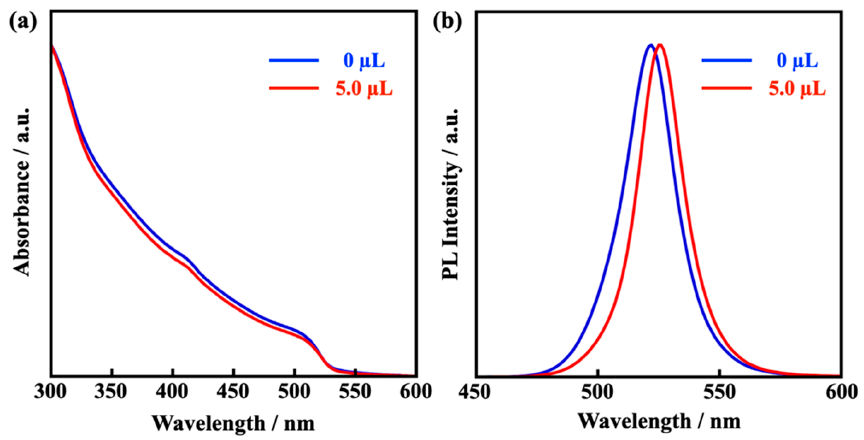
Figure 5. ( a ) UV-vis absorption spectra and ( b ) PL spectra of the MAPbBr 3 PeQDs without water (0 µL) and water-assisted (5 µL).